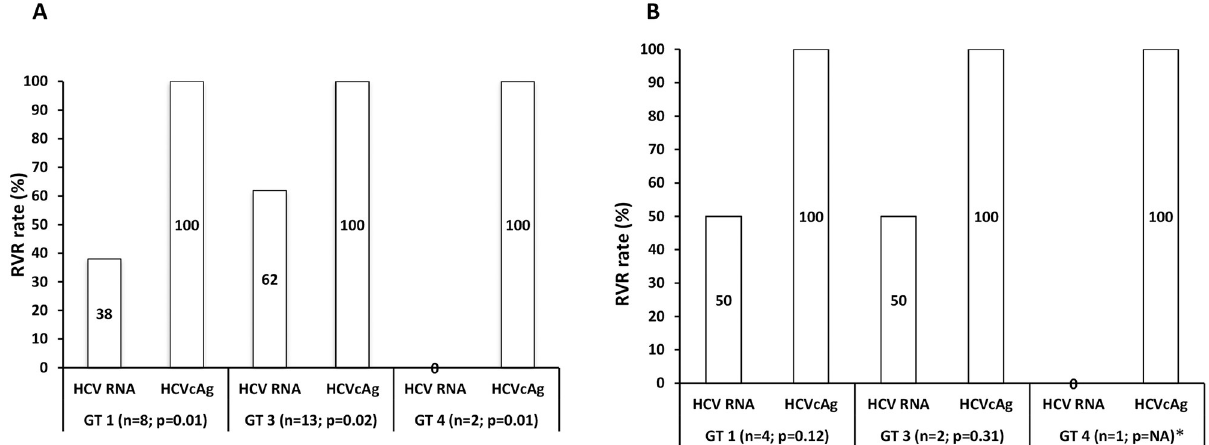
Fig 6. RVR rate in various genotypes (A) Treatment-na ï ve. (B) Previously treated. Abbreviations: HCV, hepatitis C virus; RNA, ribonucleic acid; HCVcAg, RVR, ribonucleic acid; hepatitis C virus core antigen; RVR, rapid virological response; GT, genotype; � NA: not applicable.